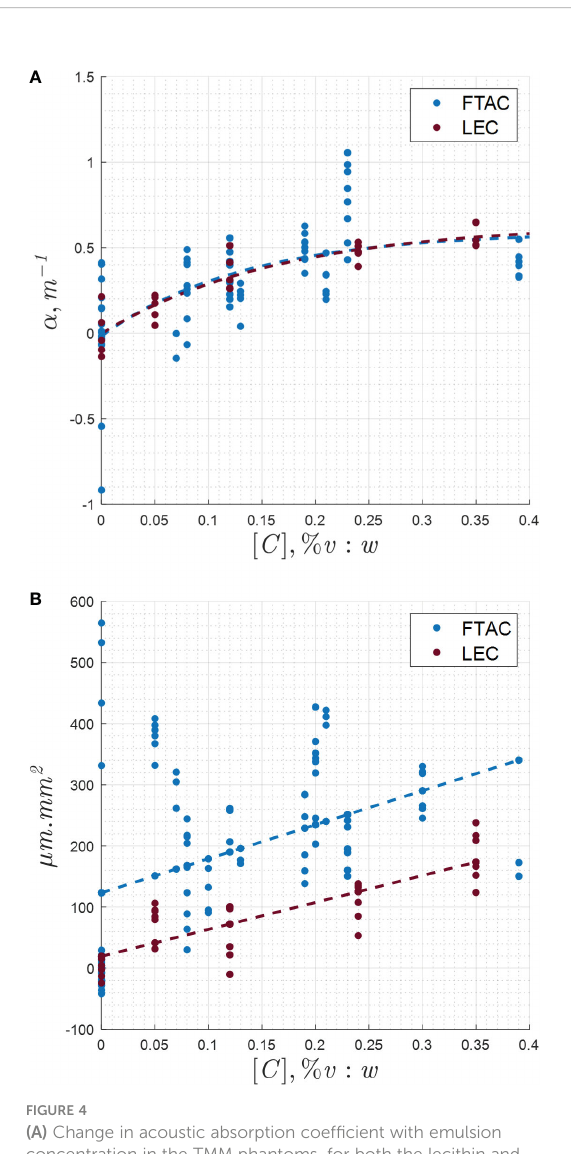
FIGURE 4 (A) Change in acoustic absorption coef fi cient with emulsion concentration in the TMM phantoms, for both the lecithin and F 8 TAC 18 surfactants. (B) MR-ARFI displacement response with varying emulsion concentration and